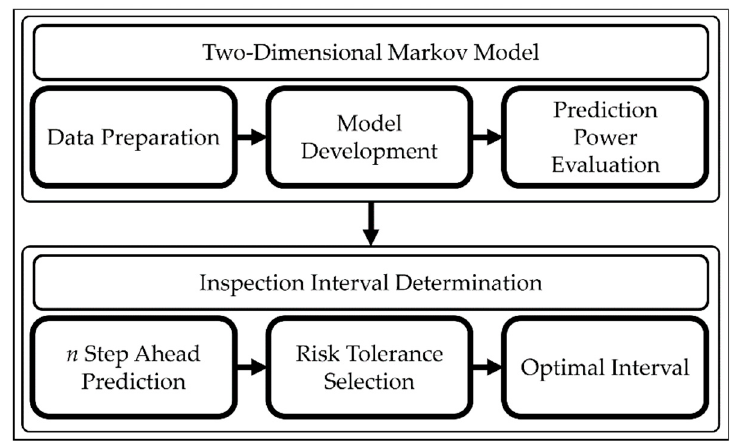
Figure 3. Steps conducted in this study.